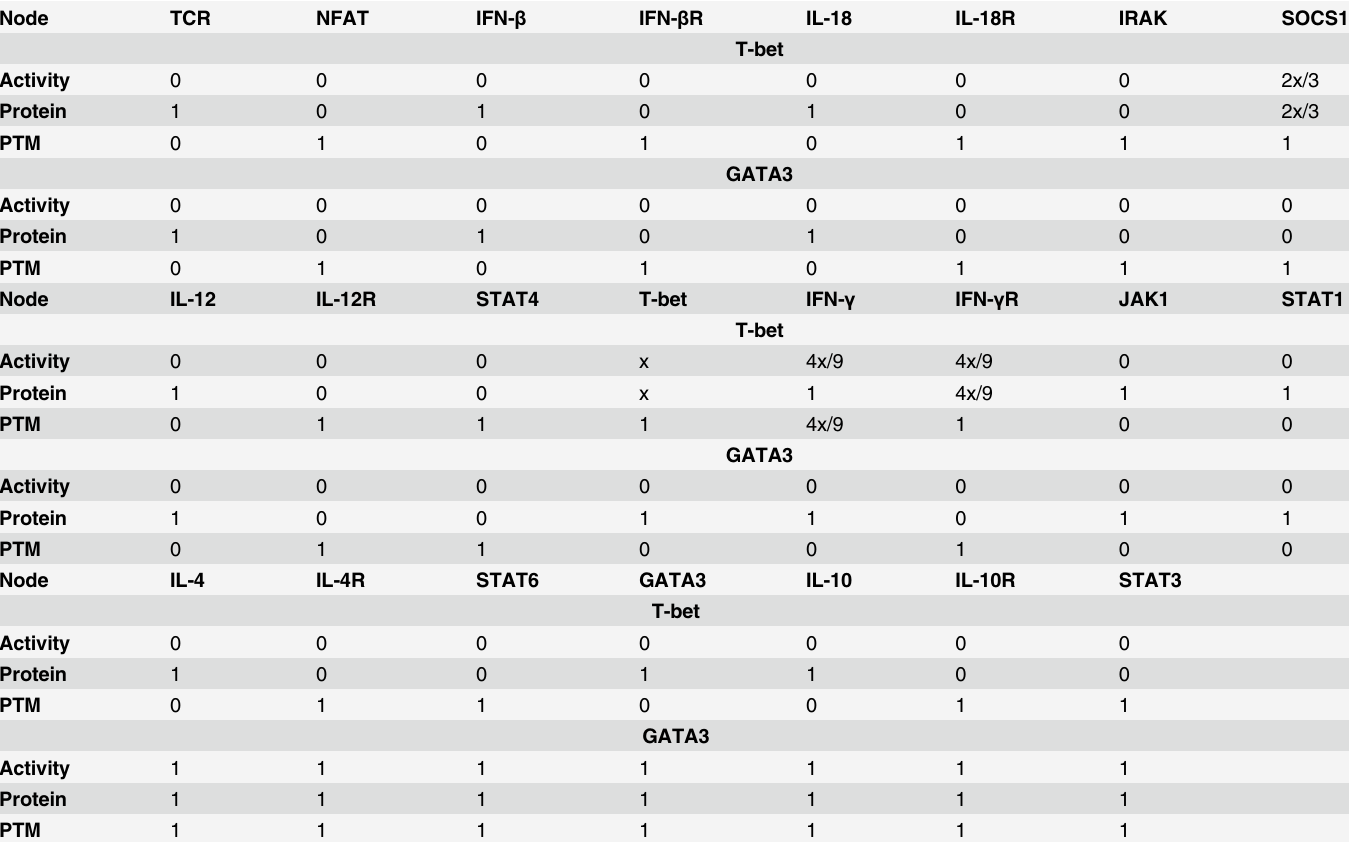
Table 1. The stable states of the Th